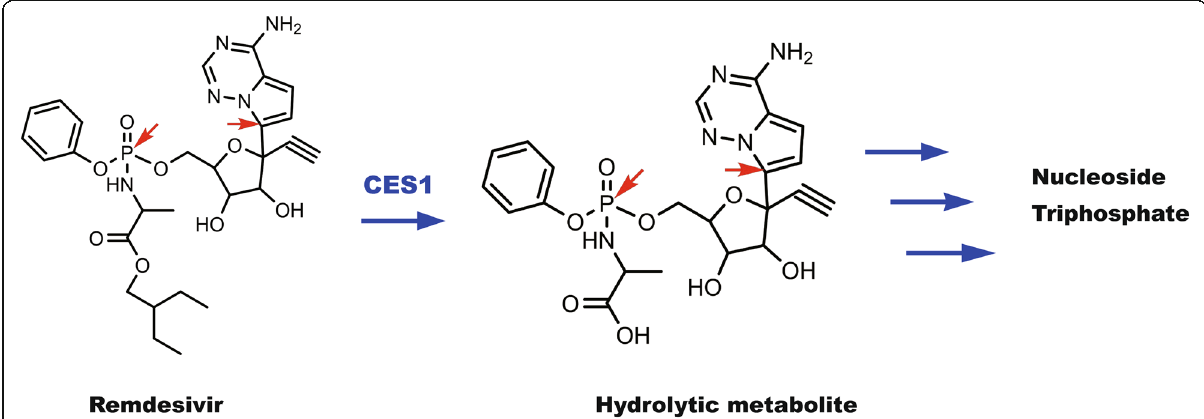
Fig. 2 Therapeutic activation of remdesivir. This antiviral agent undergoes hydrolysis followed by several phosphorylation steps to form the antiviral metabolite nucleoside triphosphate. In human, the hydrolysis is achieved by CES1 but enzyme(s) for phosphorylation remains to be